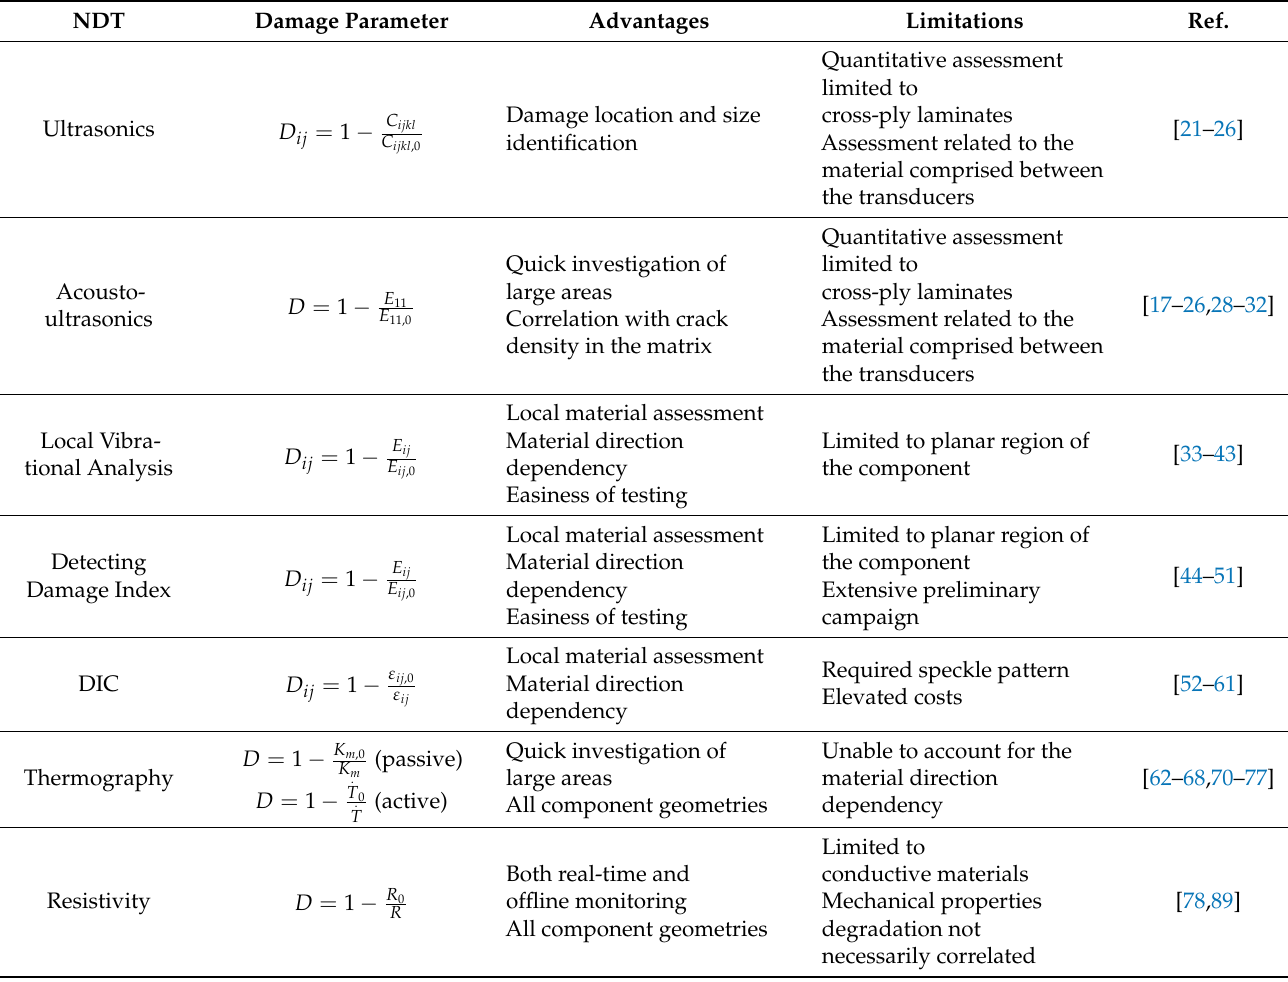
Table 1. Summary of the investigated NDTs and the related damage